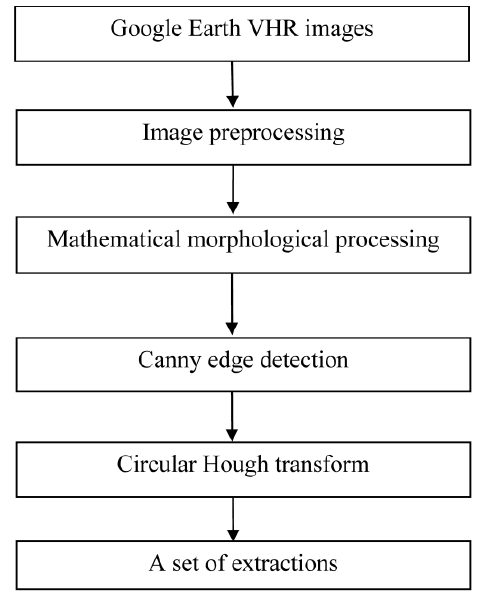
Figure 3. Work flow of the proposed automatic TQS extraction